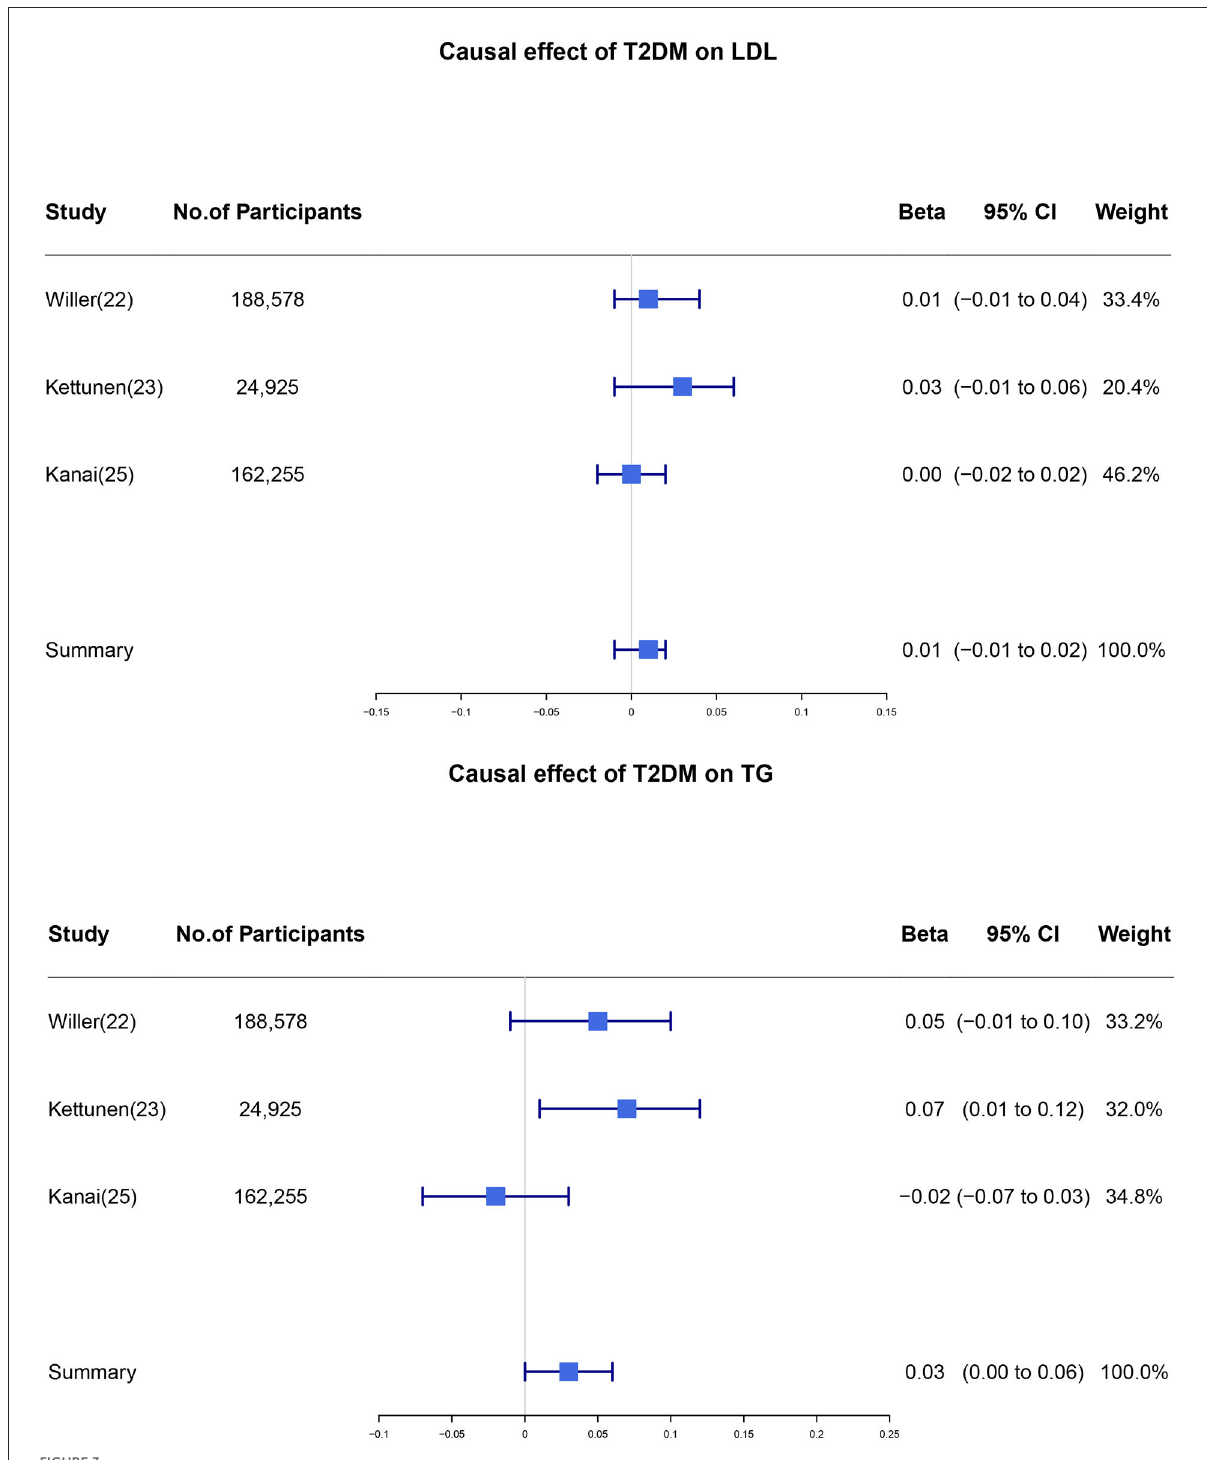
FIGURE3 Individual and pooled estimate of the causal effect of T2DM on the level of LDL and TG after sensitivity analysis. We removed the study which generated heterogeneity in our meta-analysis and the individual and pooled estimates of the causal effect of T2DM on the level of LDL and TG were re-analyzed. T2DM, type 2 diabetes mellitus; LDL, low-density lipoprotein; TG, triglycerides; CI, confidence